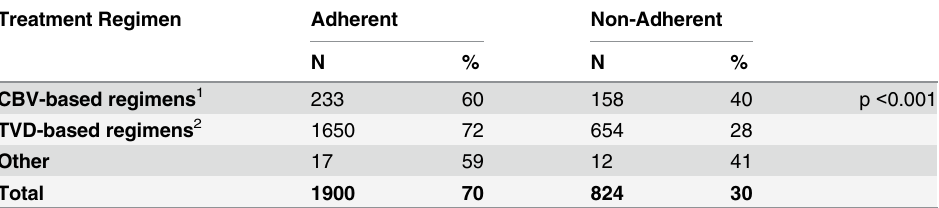
Table 3. Adherence to prescribed PEP regimen (N = 2731).